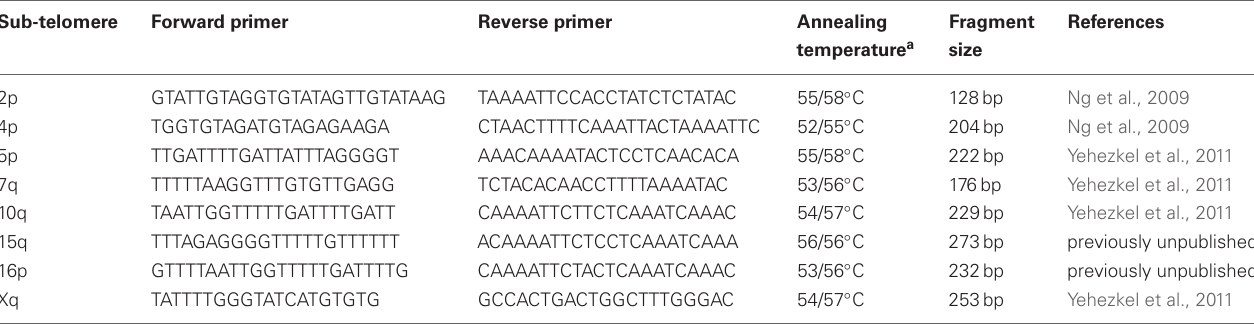
Table 1 | Primers for bisulfite